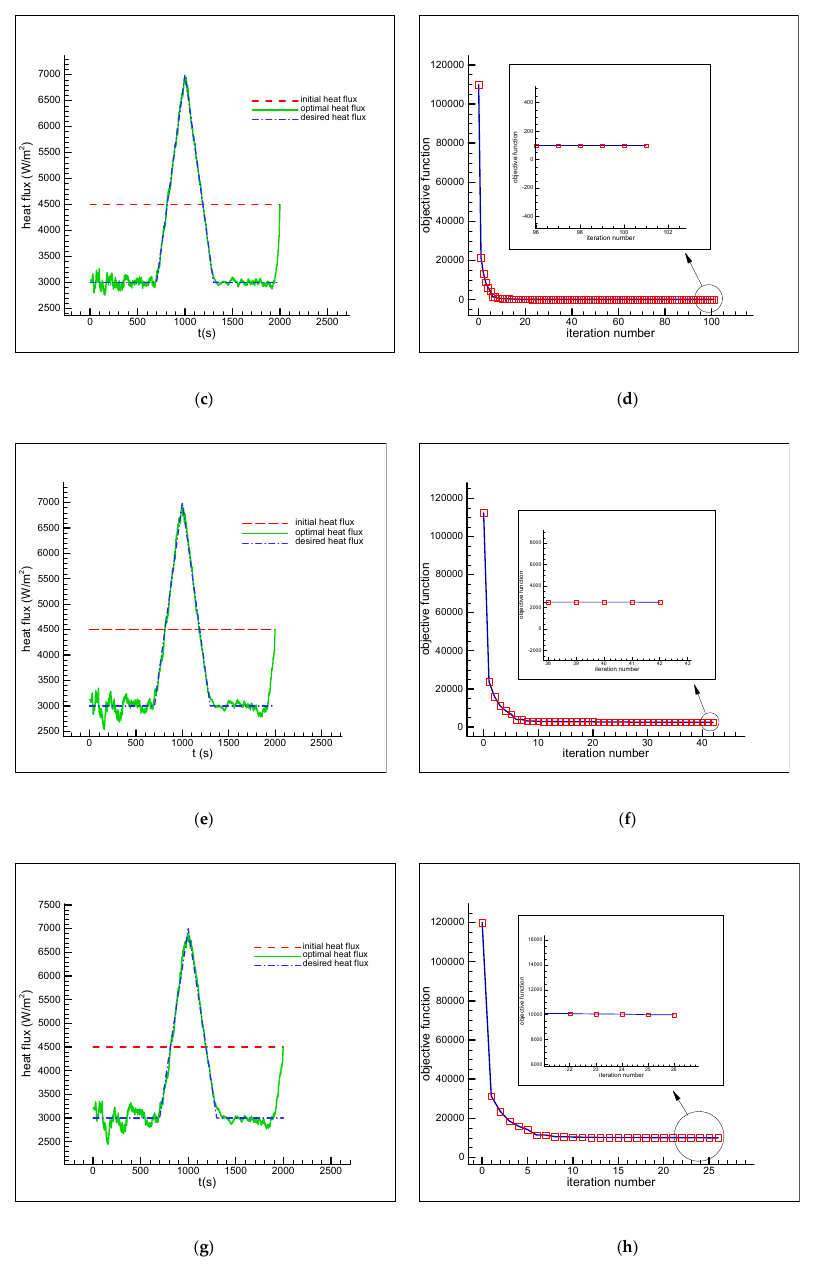
. . ( t ) = q q using an initial guess triangular initial Test case 3